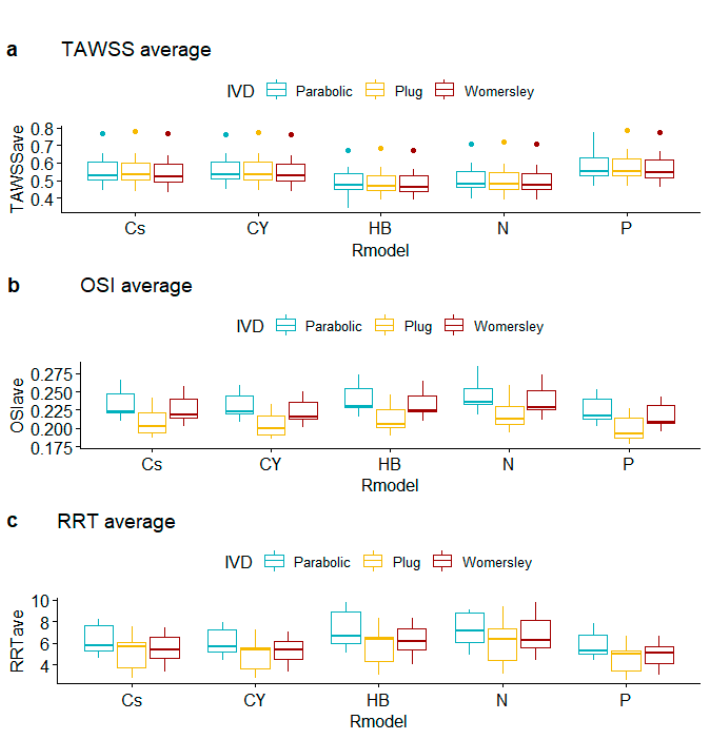
Figure 7. Boxplots of averages of hemodynamic variables for alternative rheological models and inlet velocity distributions.